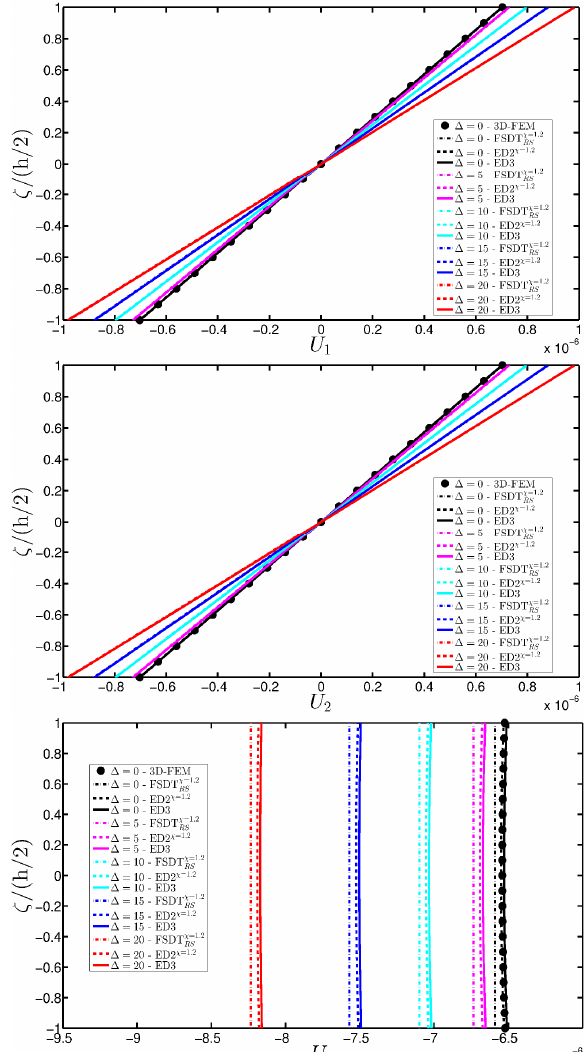
Figure 12. Through-the-thickness profiles of displacement components [m] for the CCCC isotropic square plate computed at the point A for different HSDTs. The effect of the damage is investigated by varying the parameters of the function Gau-3.